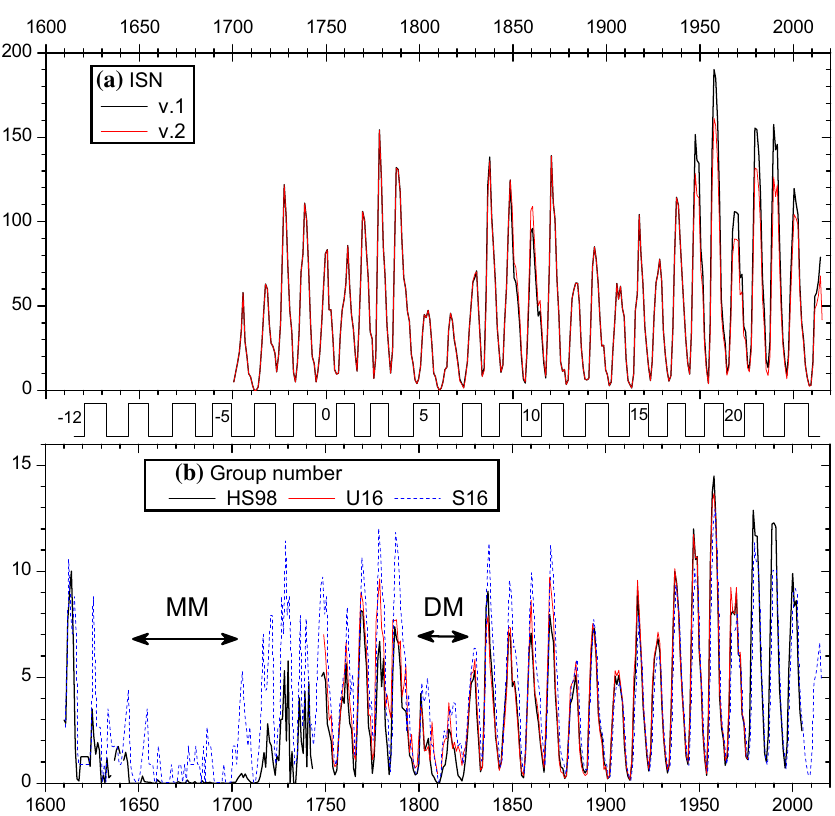
Fig. 1 Annual sunspot activity for the last centuries. a International sunspot number series versions 1 and 2 (the latter is scaled with a 0.6 factor, see SILSO, http://sidc.be/silso/datafiles). b Number of sunspot groups: HS98—(Hoyt and Schatten 1998); U16—(Usoskin et al. 2016b); S16—(Svalgaard and Schatten 2016). Standard (Zürich) cycle numbering is shown between the panels. Approximate dates of the Maunder minimum (MM) and Dalton minimum (DM) are shown in the lower